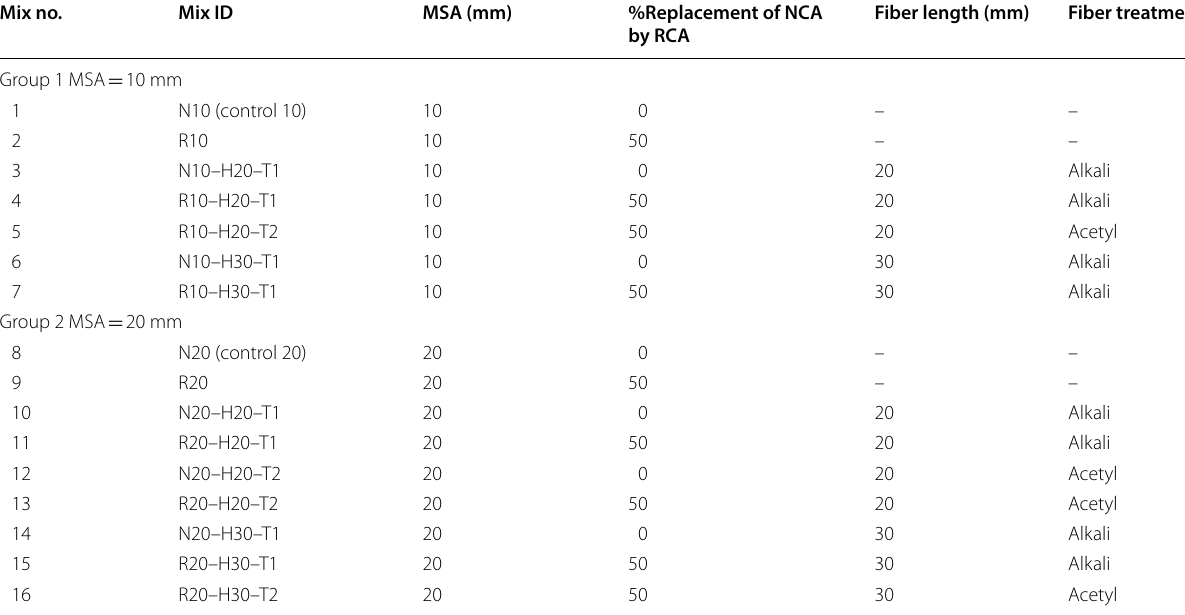
Table 2 Identification of the concrete mixes.